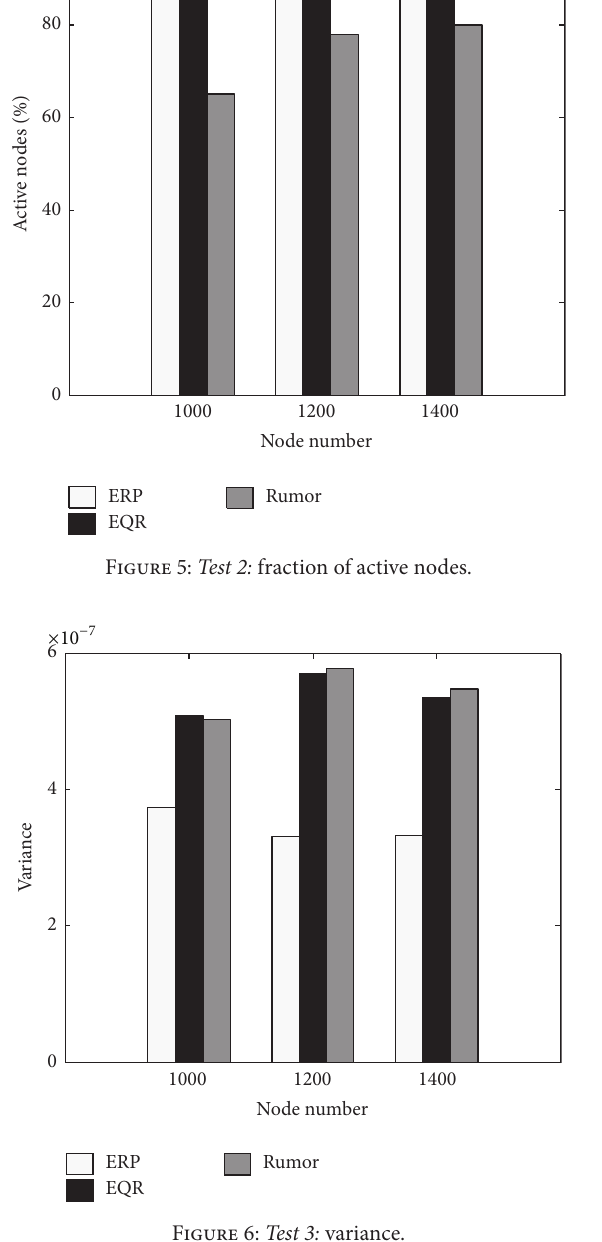
Figure 6: Test 3: variance.